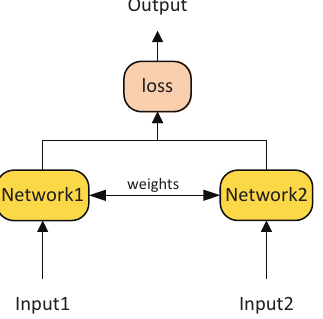
Figure 2. The architecture of the Siamese network. A novel architecture based on NLSTM and Pseudo-Siamese network calling PSNLSTM is proposed in this paper. Two NLSTM networks with different time steps are adopted